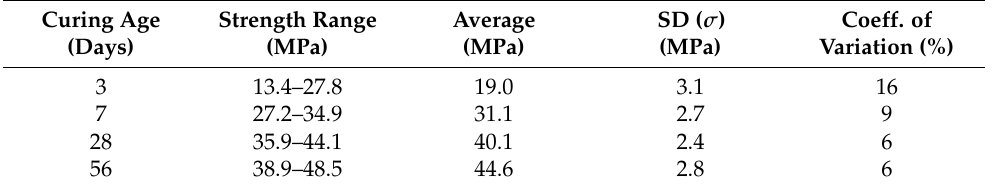
Table 3. Statistical analysis on the compressive strength of CFB fly ash-BFS-cement mixed mortar (16